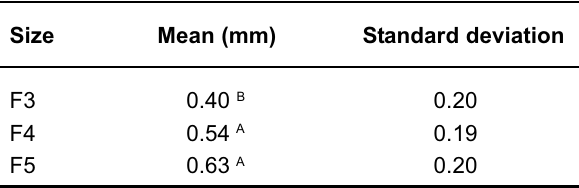
Means followed by different letters differ significantly (p<0.05; ANOVA and Tukey’s